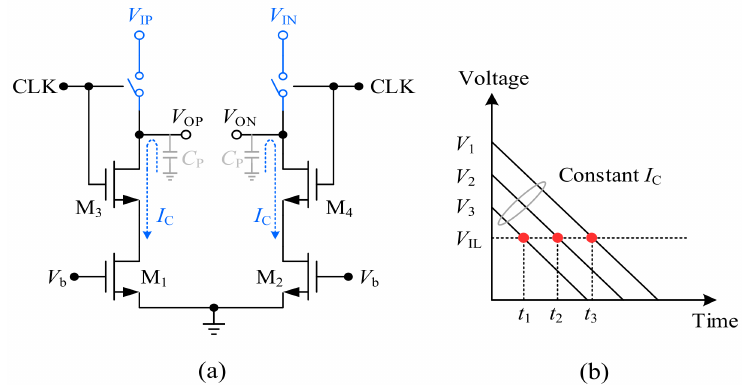
Figure 4. ( a ) VTC circuit based on variable voltage. ( b )operation principle.